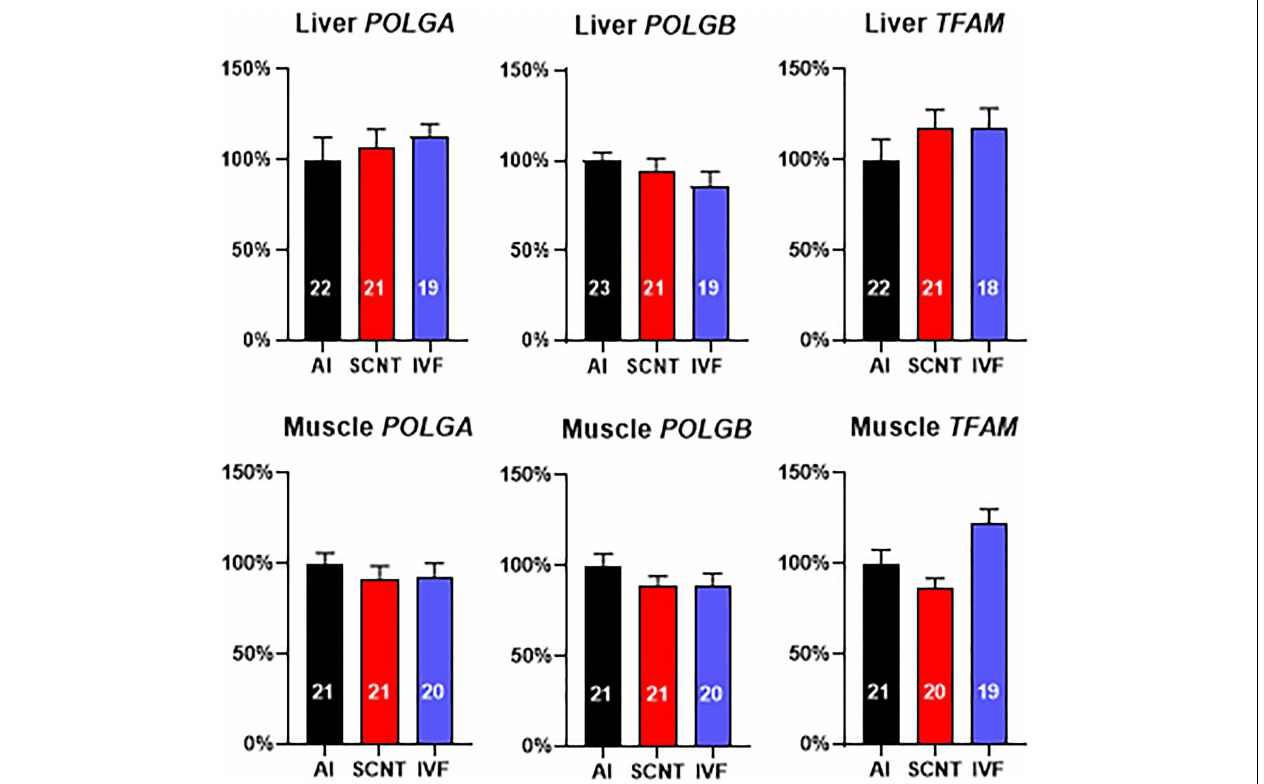
FIGURE 3 | Somatic cell nuclear transfer (SCNT) does not affect the expression of three nuclear-encoded genes pivotal for mitochondrial DNA (mtDNA) replication. Effect of SCNT on POLGA , POLGB , and TFAM transcript abundance in liver and skeletal muscle as compared with in vitro fertilization (IVF) and artificial insemination (AI) controls at day 80 of gestation. Means ± SEM are shown; treatment group was not significant (ANOVA general linear model; P > 0.05). The number of fetuses analyzed for each parameter is given within bars.